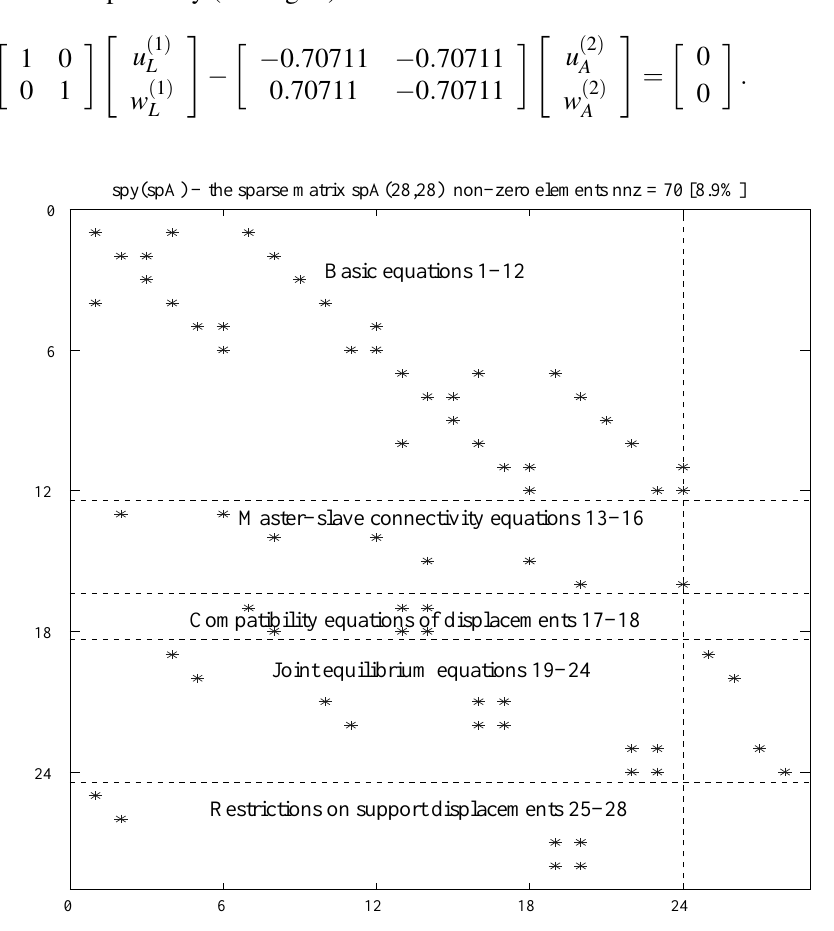
Fig. 7. Sparsity pattern of matrix spA of the cantilever truss